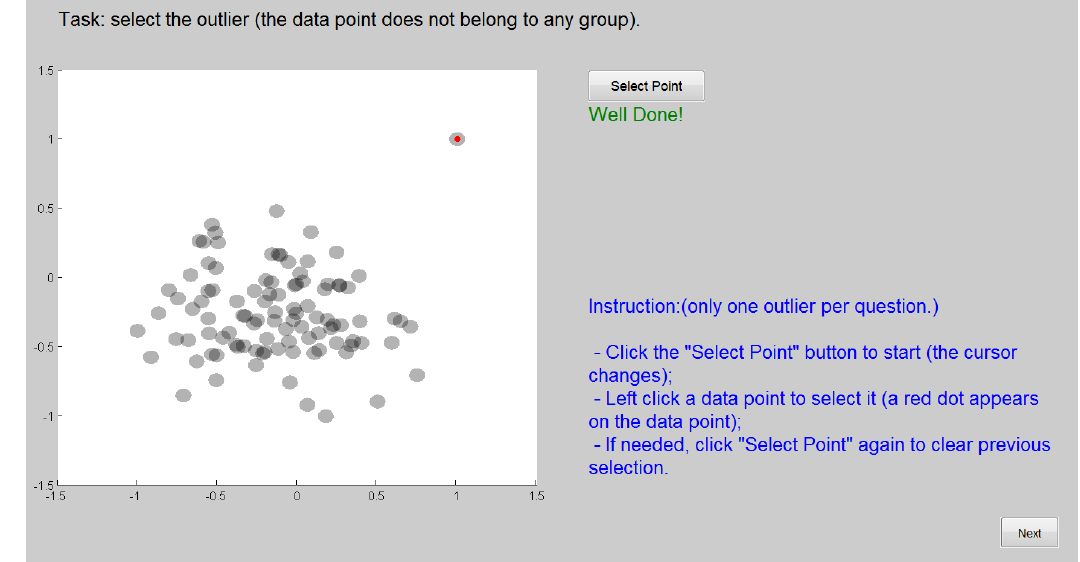
Figure 2. The training interface for the outlier task that includes the instructions (bottom right corner) and feedback (‘Well Done!’ for a correct